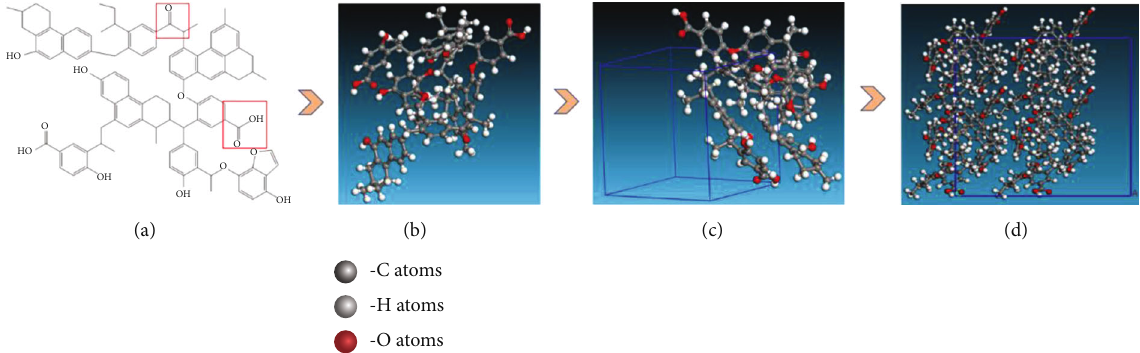
Figure 1: Coal molecular model: (a) long- fl ame coal macromolecular structure, (b) long- fl ame coal molecule lowest energy structure model, (c) long- fl ame coal molecule lowest energy structure model with the periodic boundary condition, and (d) supercell expansion of long- fl ame coal molecule with periodic boundary conditions. Table 1: Detailed parameters of the molecular model. Element formula